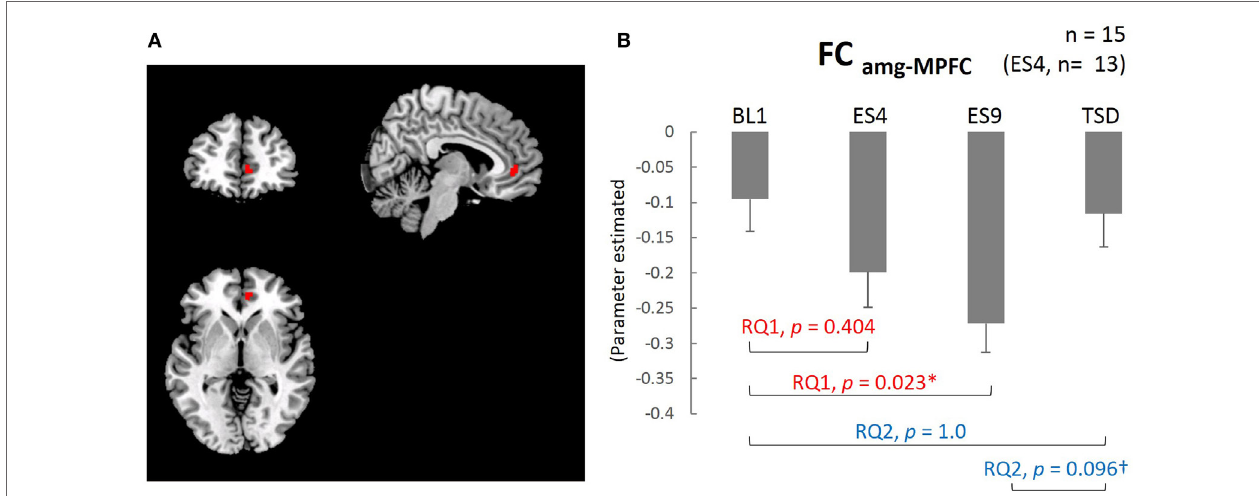
FigUre 4 | Medial prefrontal cortex (MPFC) ROI and functional connectivity between the amygdala and MPFC. (a) MPFC ROI: peak MNI coordinate ( x , y , z ) = (8, 44, 0) mm, 34 contiguous voxels; clusters are rendered on a T1 anatomical reference image displayed in neurological convention, with the left side corresponding to the left hemisphere. MNI, Montreal Neurological Institute template. (B) Functional connectivity between the amygdala and MPFC for the four sleep conditions. * p < 0.05, † p < 0.1; p values were adjusted for multiple comparison. Data were analyzed based on the following two research questions: (RQ1) Comparison between BL1 and ES9 to investigate the effect of extended sleep ( t test for KSS and STAI-S and Wilcoxon signed-rank test for PANAS-NA); (RQ2) Comparison between BL1 and TSD to determine whether the TSD would erase the effect of sleep extension and whether the subjective indices after TSD would be comparable to those at the baseline level. RQ, research question; FC amg–MPFC , functional connectivity between the amygdala and medial prefrontal cortex; BL1, baseline Day 1; ES4, extended sleep Day 4; ES9, extended sleep Day 9; TSD, total sleep